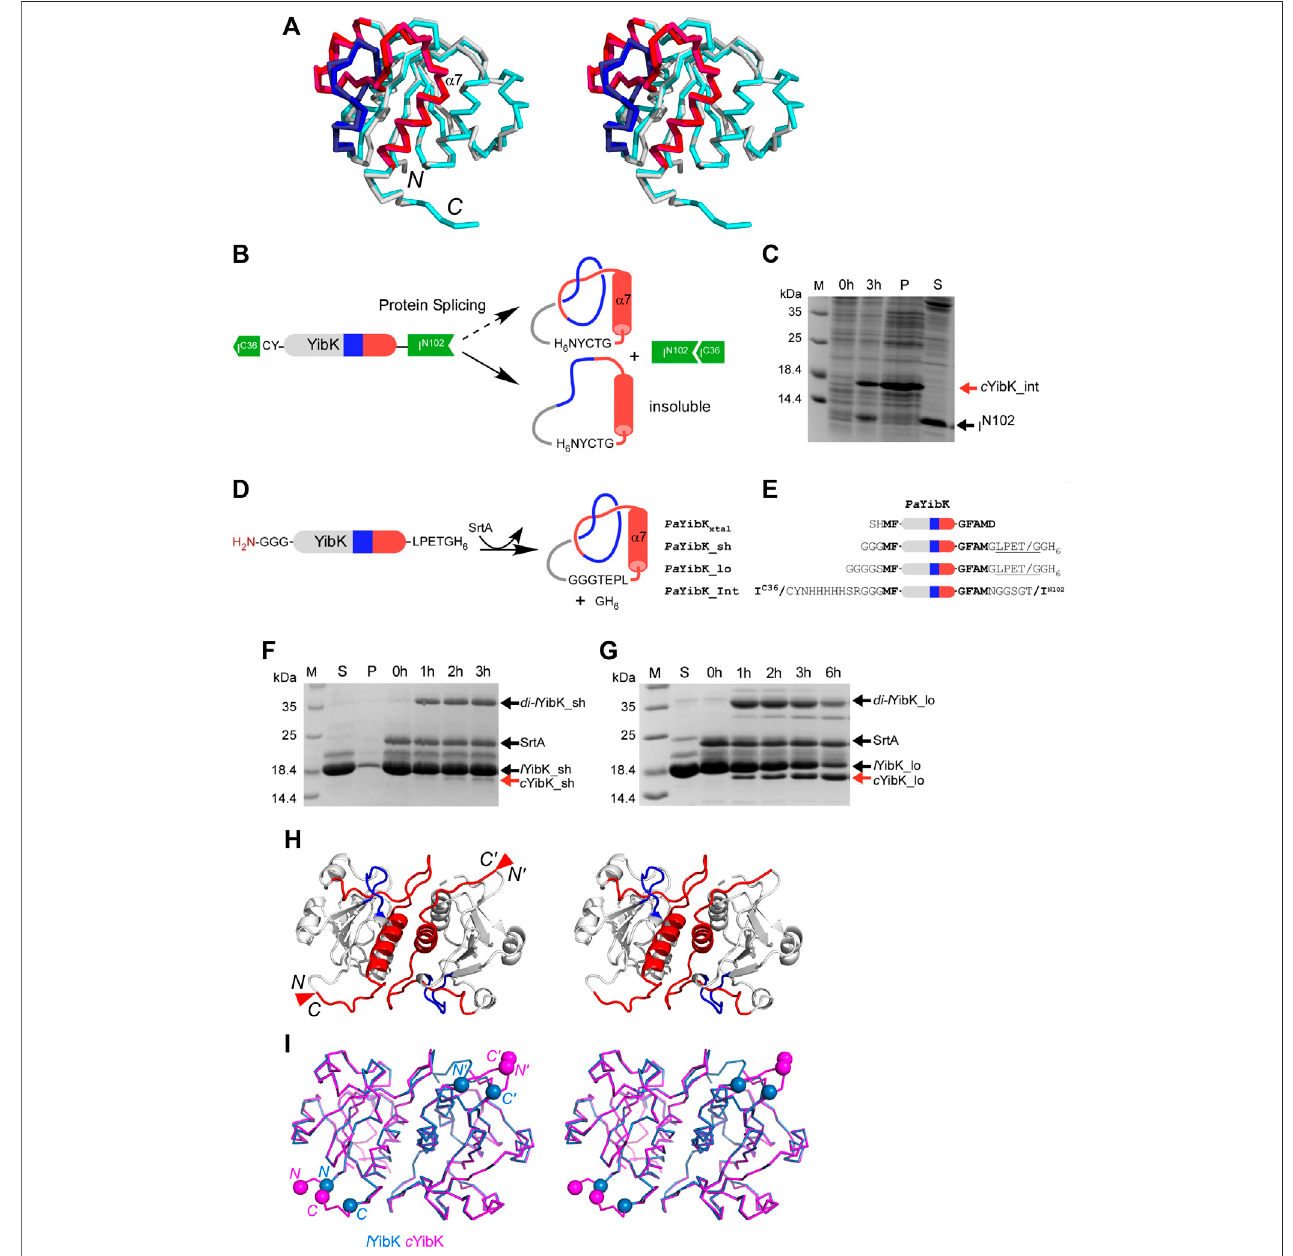
FIGURE 1 | Cyclization and structural analysis of a truly knotted Pa YibK. (A) A stereo view of the superposition of Pa YibK (pdb:6qkv) and Ha YibK (pdb:1j85) in ribbon presentation. (B) Schematicrepresentation oftheexperimentalstrategyused forcyclizationofYibKbythesplit-inteinstrategy. (C) Invivo backbonecyclizationof YibK by protein trans -splicing. Spliced YibK and N-terminal fragment are indicated; M, Molecular weight marker P, insoluble fraction; S, soluble material. (D) Backbone cyclization of YibK using sortase A (SrtA). (E) Constructs used in backbone cyclization with different lengths of linkers connecting the termini. (F) and (G) Impact of linker lengths on the in vitro sortase ligation ef fi ciency monitored by SDS-PAGE of linear YibK with short (F) and long (G) poly-glycine linkers annotated as l YibK_sh and l YibK_lo, respectively; 0 – 6 h: ligation reactions harvested at speci fi ed time points; SrtA, sortase added post-puri fi cation; di- YibK_sh/lo, undesired dimeric ligation products; c YibK_sh/lo,desiredcyclizedproducts.TheNandC-terminalextensionsofYibKfordifferentligationexperimentsareshownwiththeirnamesindicatedonthe left. (H) Astereo-viewofthecrystalstructureof c YibK_lo.ThestructuresareshownincartoonrepresentationwiththeknottingloopandthreadingC-terminalhelixshown in blue and red, respectively. The positions of the path closures between N- and C-termini are indicated by red triangles. (I) Comparison of the crystal structure of linear Pa YibK(6qkv;orchidblue)and c YibK(6qh8;magenta).TheC α atomsoftheS1andD155of Pa YibKareshowninorchidbluespheres,andthepositionsofpathclosures in c YibK are indicated by magenta triangles as in (H)